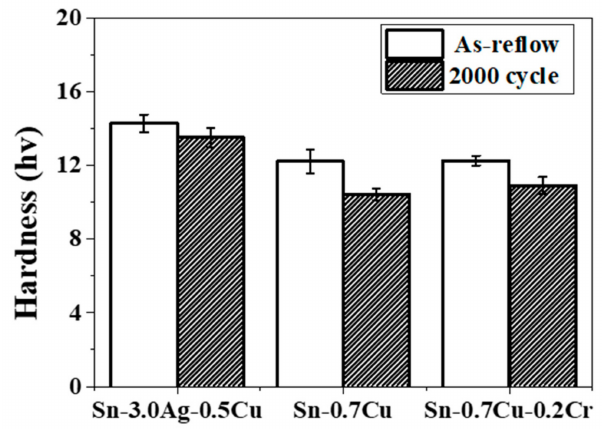
Figure 10. Hardness of different